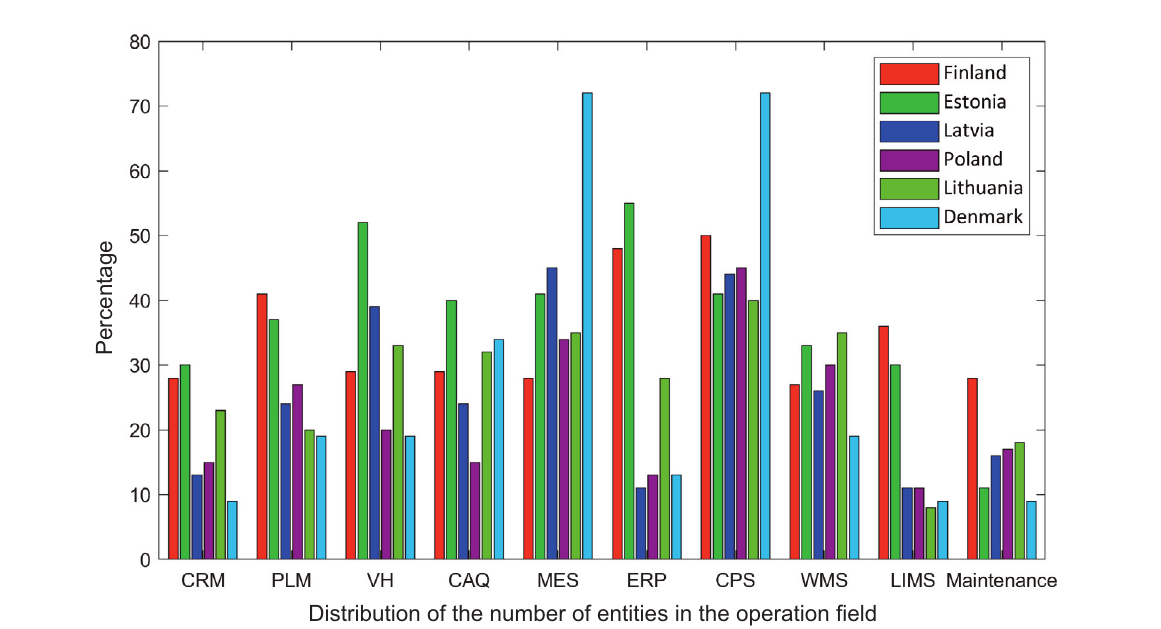
Distribution of the number of entities in the operation